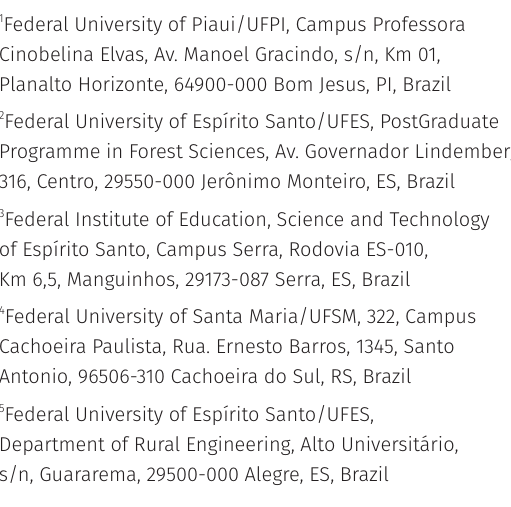
Table SI. Programming command lines in Python in ArcGIS/ArcInfo 10.2 for spatialization in fuzzy logic of the influence of the relief orientation on the risk of